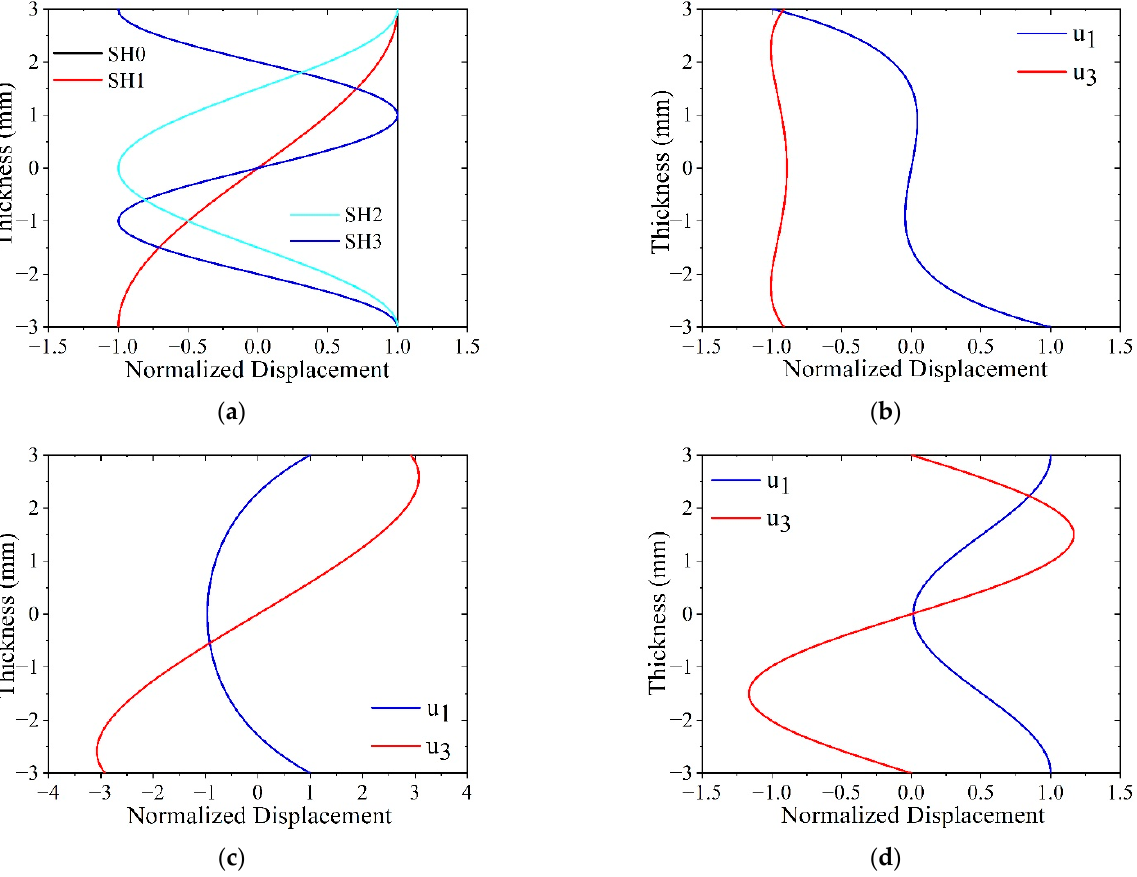
Figure 4. Wave structures, u 2 for SH modes and u 1 and u 3 for Lamb modes: ( a ) u 2 for SH0, SH1, SH2, and SH3; ( b ) A0 mode at P5(447, 2.78); ( c ) S0 mode at P6(520, 3.24); and ( d ) S1 mode at P7(602, 6.19).